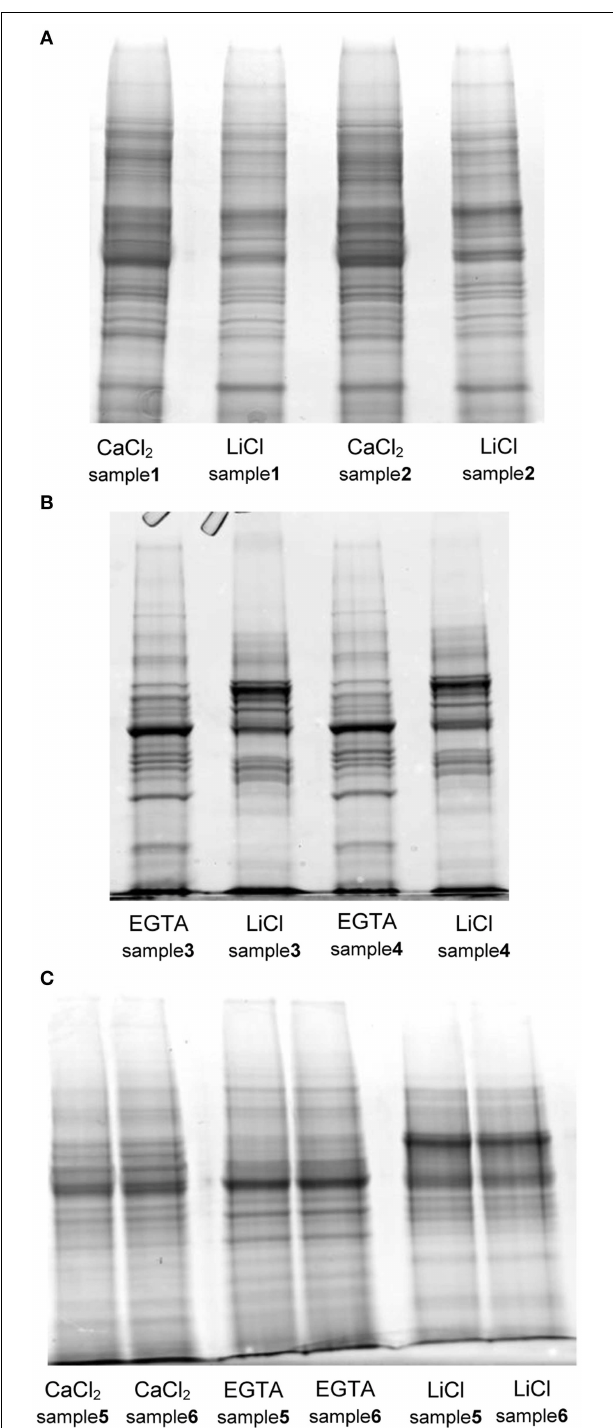
FIGURE 2 | SDS-PAGE protein profiles of the different fractions extracted with the tested protocols. (A) protocol 1, adapted from Watson et al. (2004) (B) protocol 2, adapted from Verdonk et al. (2012) (C) protocol 3 (hybrid), adapted from Verdonk et al. (2012) and Feiz et al. (2006): each lane was loaded with 20 µ g of proteins on Criterion ™ XT precast 1D gel 12% Bis-Tris (Bio-Rad). The gels were stained with Coomassie blue (InstantBlue,